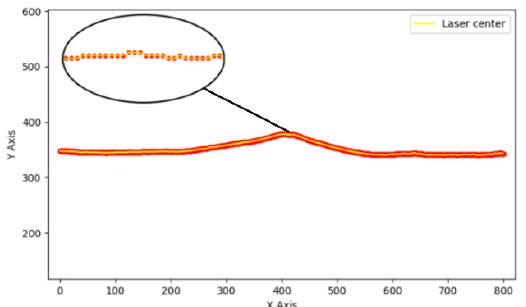
Figure 5. Extraction of the center of the laser stripe by the gray centroid